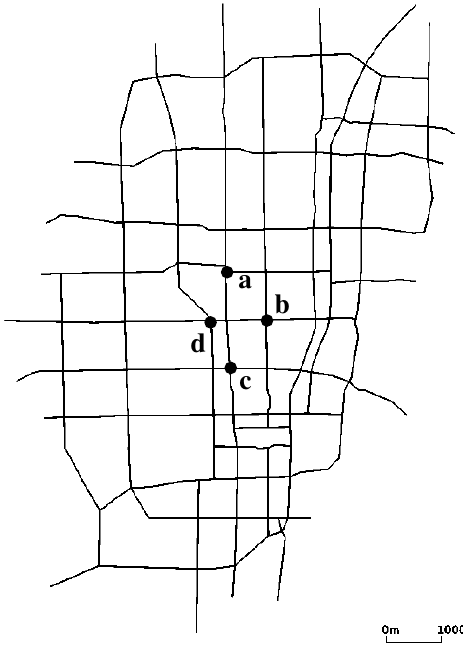
Figure 10. Kyoto City Map used in